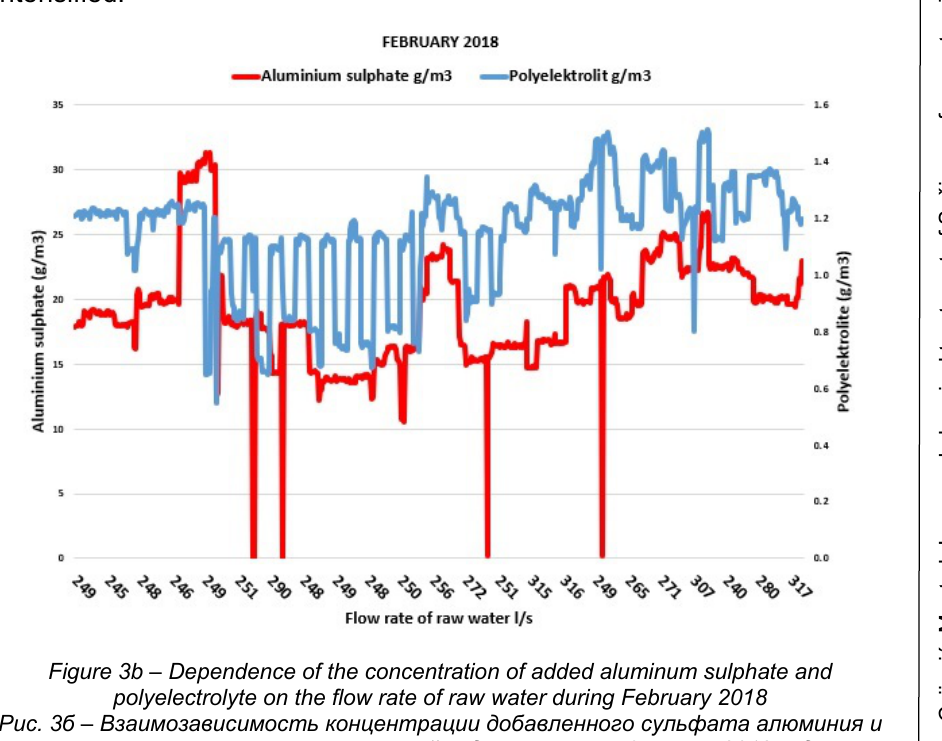
Figure 3b – Dependence of the concentration of added aluminum sulphate and polyelectrolyte on the flow rate of raw water during February